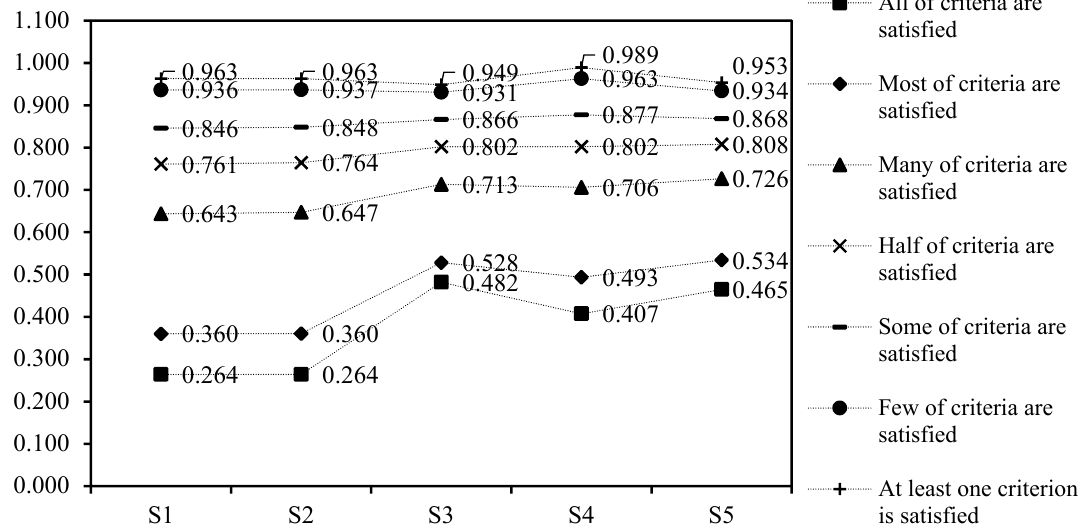
Figure 12. The external modified ordered weighted averaging (EMOWA) scores of the Kashafroud water strategies in each group viewpoint for the risk cases.